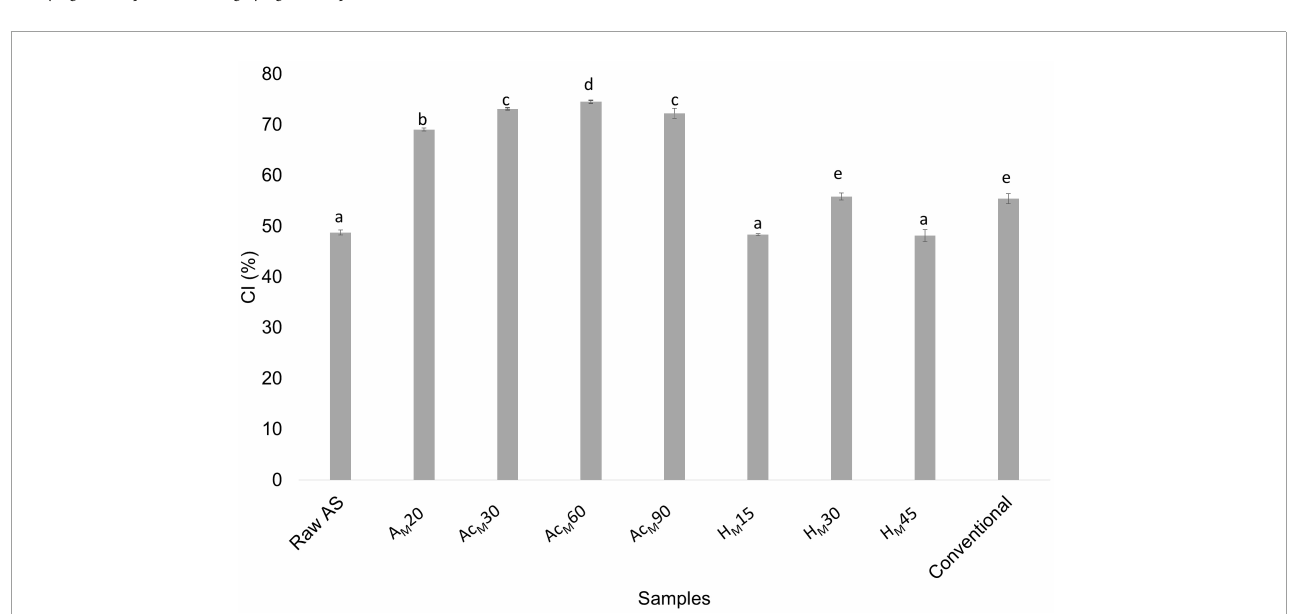
FIGURE5 CI values obtained for raw AS; alkalized sample by MAE for 20 min (A M 20); acetylated A M 20 sample for 30, 60, and 90 min (Ac M 30, Ac M 60, and Ac M 90, respectively); hydrolyzed Ac M 60 sample for 15, 30, and 45 min (H M 15, H M 30, and H M 45, respectively); and CNCs obtained using the conventional procedure (conventional). Mean ± SD, n = 3. Different superscripts indicate statistically significant different values ( p <